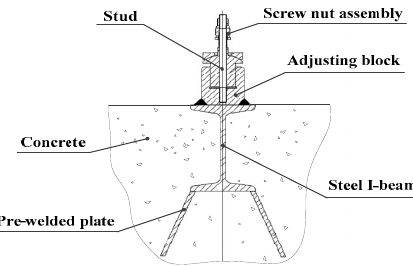
Figure 2. A single-step approach to constructing machine tool foundations [12].